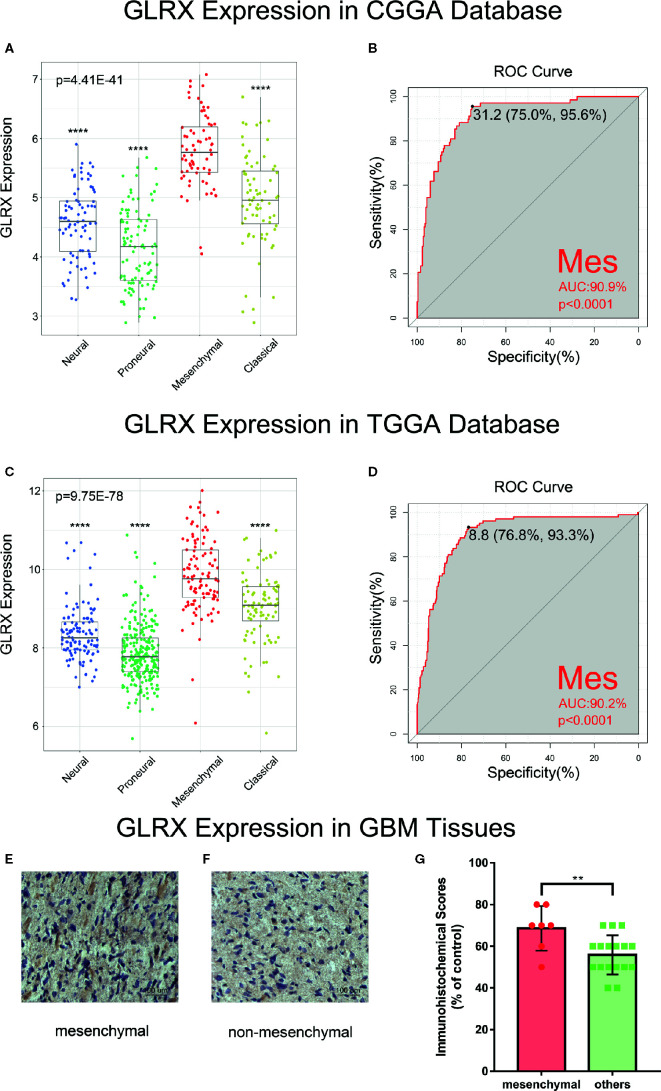

GLRX is a potential marker for malignant subtypes of gliomas. (A, C)
GLRX was highly expressed in the mesenchymal subtype in the CGGA and TCGA databases. (B, D) ROC curve analysis showed that GLRX was highly sensitive and specific to predict the mesenchymal subtype in the CGGA and TCGA databases. (E, F) The representative photos of IHC staining of GLRX in different TCGA molecular subtypes. Scale bar is 100 um. (G) The immunohistochemical scores of GLRX were measured in different TCGA molecular subtypes. Respectively, 7 and 17 patients were from GBM. Differences between groups were tested by Tukey’s multiple comparisons test. ** and **** indicate p<0.01 and p < 0.0001, respectively.